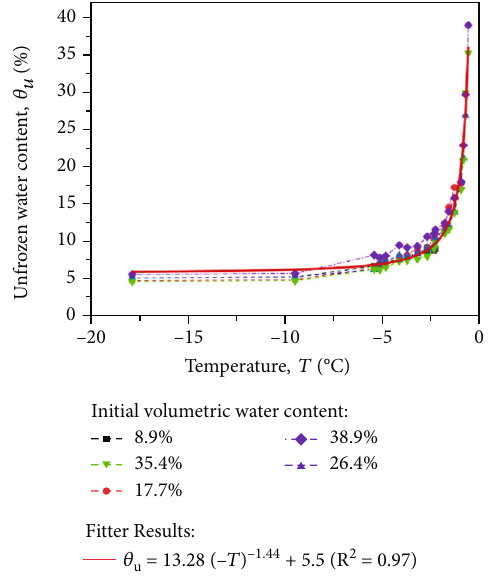
Figure 2: The soil freezing characteristic curve (SFCC) of the Qinghai silty clay.